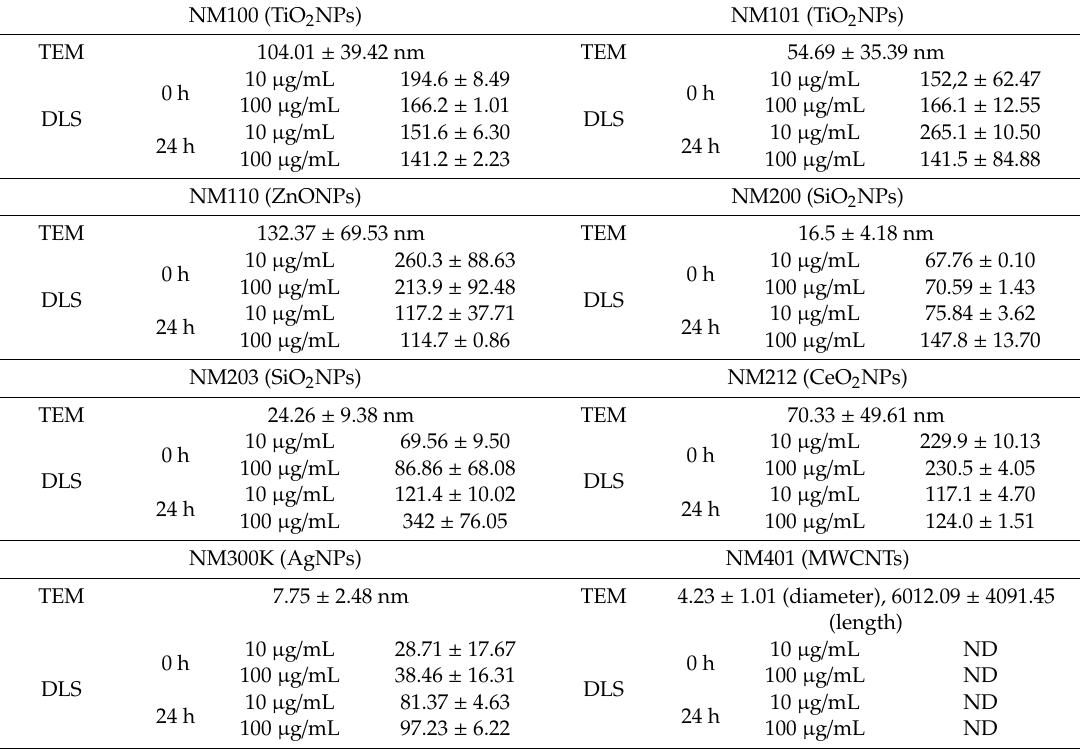
Table 1. Comparison of pristine sizes (transmission electron microscopy, TEM) and 10 and 100 µ L dispersions (dynamic light scattering, DLS). Sizes were evaluated just after the dispersion procedure and 24 h